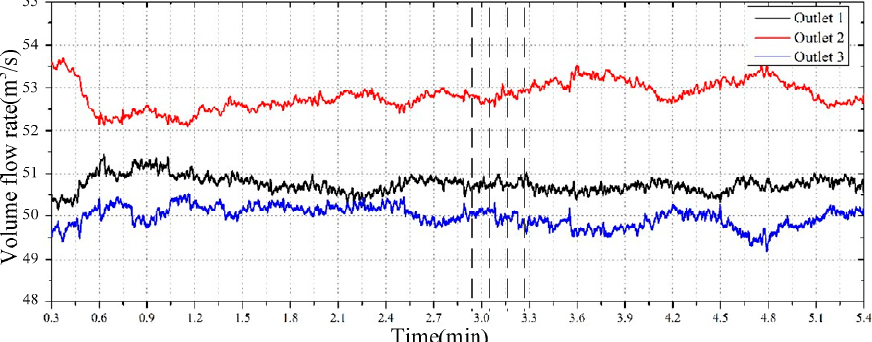
Figure 6. Variations in the volume flow rates (original model).